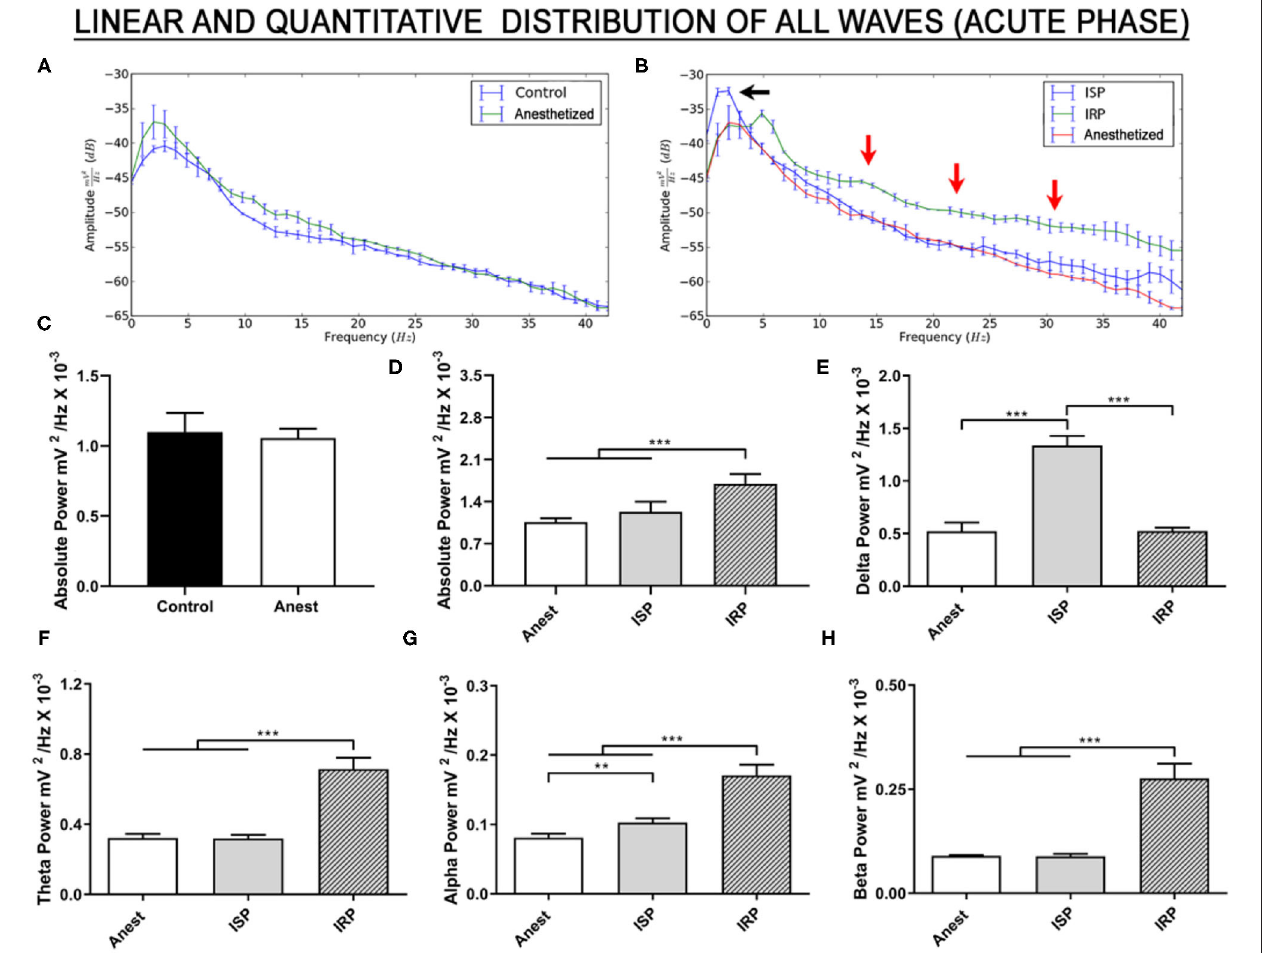
FIGURE 2 | Linear frequency distribution of the animals submitted to the MCAO surgery during the acute phase. (A) Linear frequency distribution between the anesthetized and control (conscious) animals. (B) Linear frequency distribution of the anesthetized, ischemic stroke, and immediate reperfusion phase animals. (C) Quantitative electroencephalographic data on the absolute brainwave power of the control and anesthetized animals. (D) Quantitative electroencephalographic data on the absolute brainwave power, (E) Relative delta wave bandpower, (F) Relative theta wave bandpower, (G) Relative alpha wave bandpower, and (H) Relative beta wave bandpower. The data are expressed as the mean ± SD ( n = 6 animals per group; * p < 0.05, ** p < 0.01, and *** p < 0.0001). Anest, anesthetized animals; ISP, ischemic stroke phase; IRP, immediate reperfusion